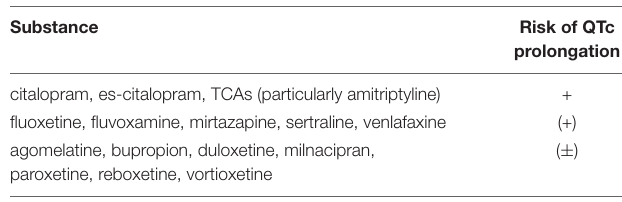
TABLE 1 | Relative risk of QTc prolongation with frequently used antidepressant drugs.